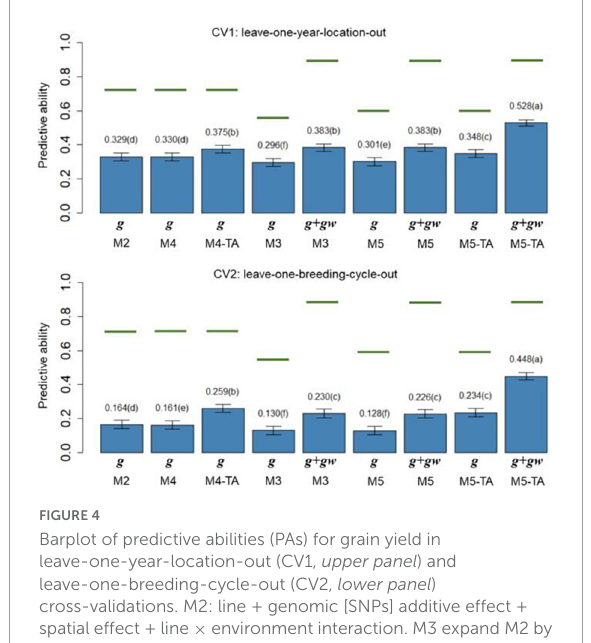
FIGURE4 Barplot of predictive abilities (PAs) for grain yield in leave-one-year-location-out (CV1, upper panel ) and leave-one-breeding-cycle-out (CV2, lower panel ) cross-validations. M2: line + genomic [SNPs] additive effect + spatial effect + line × environment interaction. M3 expand M2 by adding a genomic [SNPs] additive × ECs interaction. M4 expand M2 to the multi-trait case. M4-TA is the M4 using trait-assisted (TA) genomic prediction. M5 expand M3 to the multi-trait case. M5-TA is the M4 using TA genomic prediction. Black bars are the 95% confidence interval. Differences in the letter above the bar represent significant differences between models ( P-value < 0.01). Green lines are the theoretical maximum